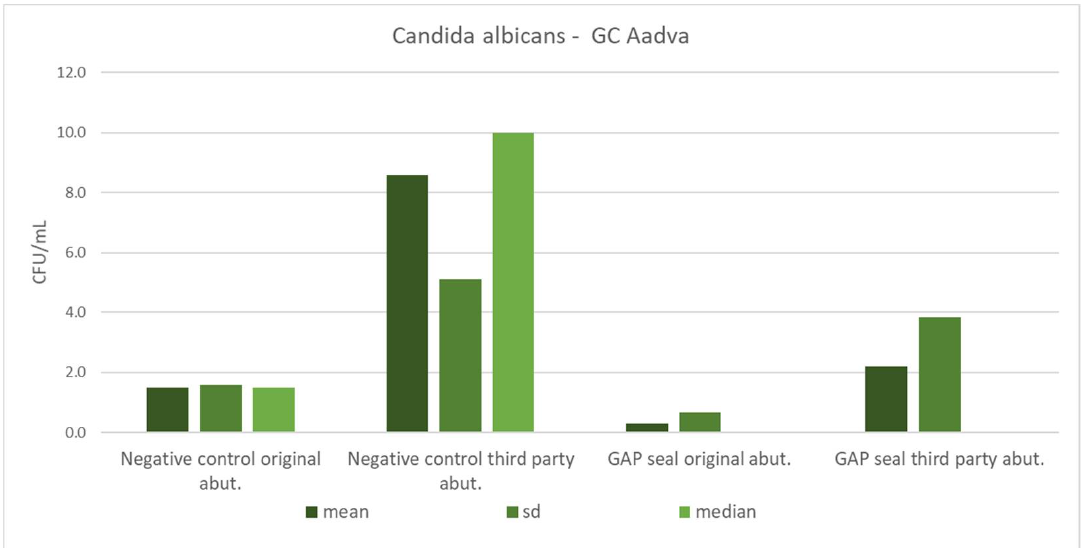
Figure 13. Mean counts of Candida albicans detected on the internal surface of GC implants depending on the abutment fabrication method (original and third-party) and the need for the use of the gap sealing material.